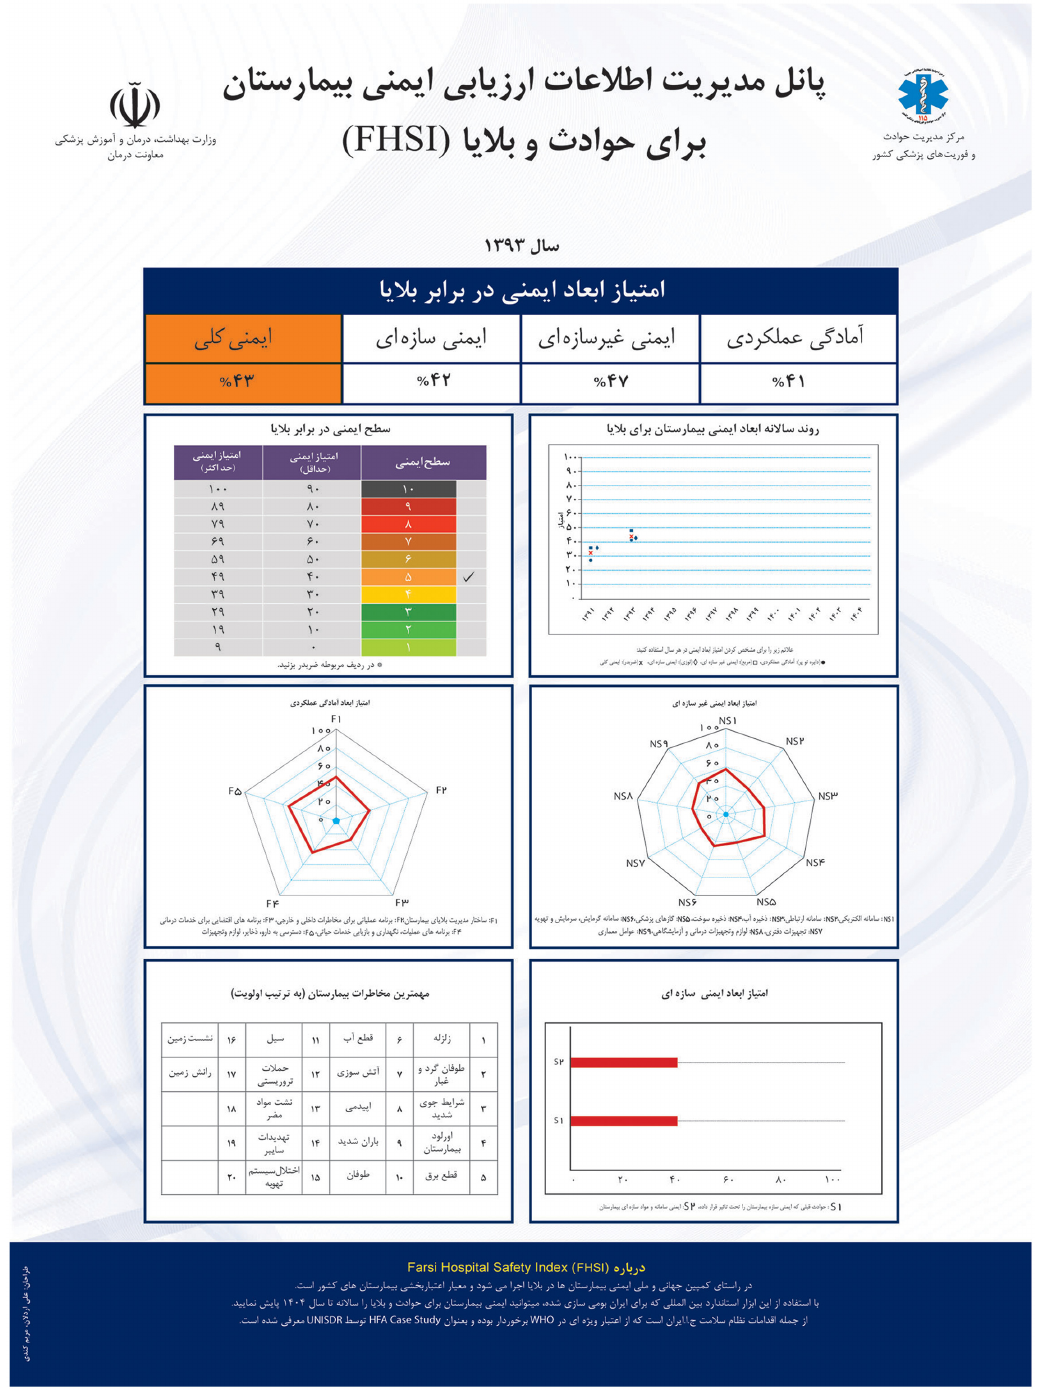
Fig 1. FSHI dashboard posted in office of Health Deputy Minister.